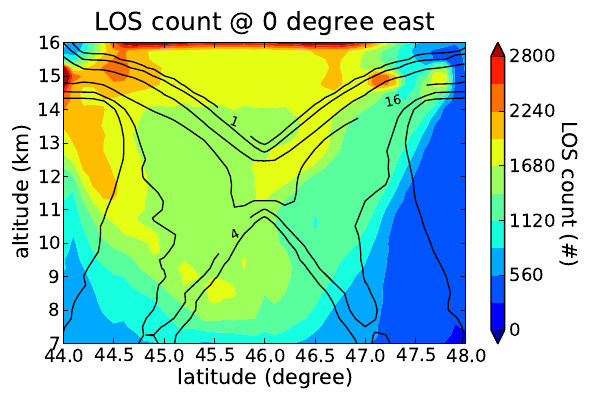
Fig. 15. The spatial distribution of measurements. The number of measurements sampling each volume element is shown.